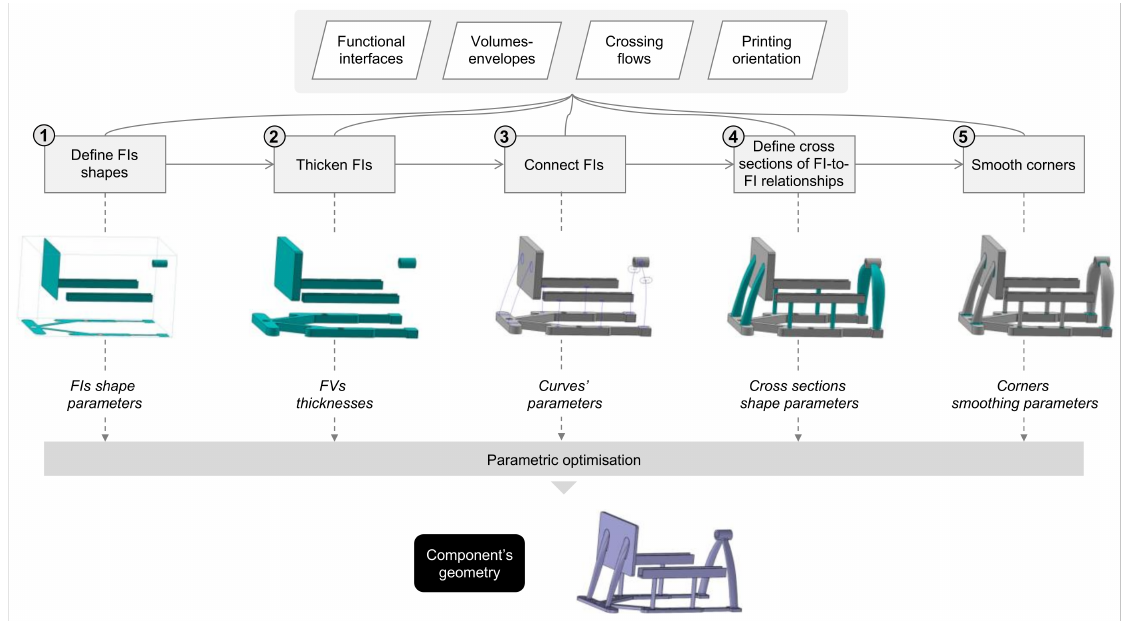
Figure 8. The proposed design methodology for part’s design illustrated via a vise’s frame based on prior research work [56].